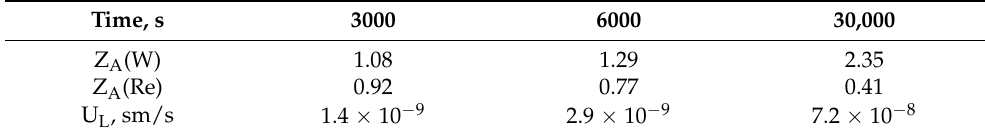
Table 3. Compositions of solutions for electrochemical studies. Time, s 3000